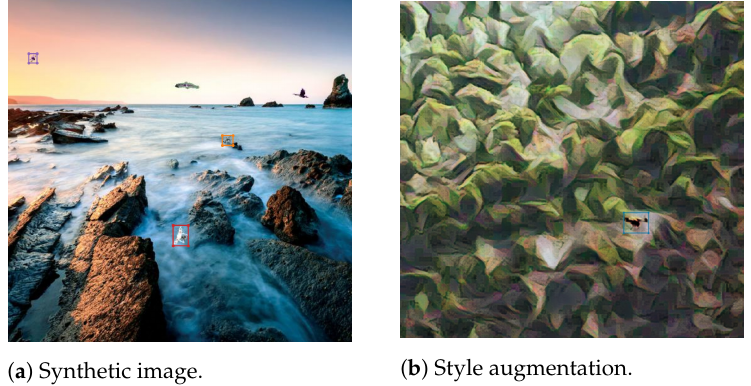
Figure 21. Examples of different augmentations. In ( a ), this is a synthetic image generated with Alexis team pipeline and ( b ) is an image on which style augmentation [55] has been